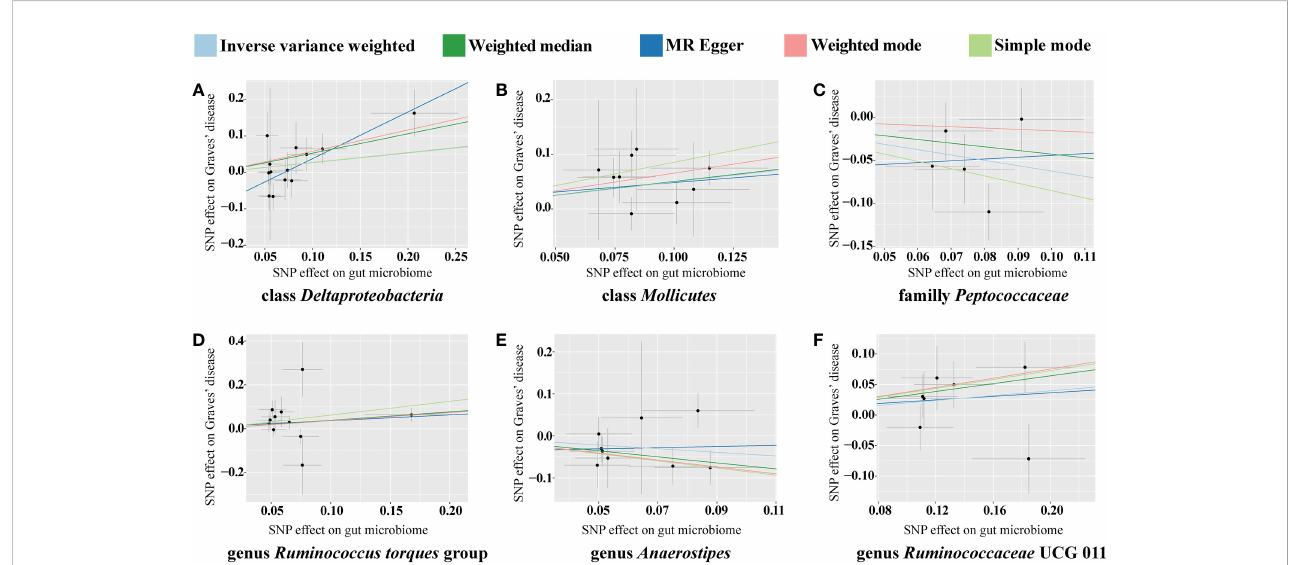
FIGURE 3 Scatterplot of the effect of the gut microbiome on Graves ’ disease (GD). The effect of the gut microbiome on GD is calculated through single nucleotide polymorphisms (SNPs), which provide an association between the gut microbiome and GD through fi ve Mendelian randomization (MR) methods (A – F) . In each plot, each dot indicates one SNP from the gut microbiome genome-wide association study (GWAS) summary dataset. The x -axis values represent the effect of SNPs on the gut microbiome. The numerical value of the x -axis position of each dot equals the absolute value of the b -value of each SNP, and the value of the horizontal error bar equals the standard error of the SNP from the gut microbiome GWAS summary dataset. The y -axis values represent the effect of the SNPs on GD. The numerical value of the y -axis position of each dot equals the opposite number of b -value of SNP, and the value of the vertical error bar equals the standard error of the SNP from the GD GWAS summary dataset. The b -values and standard errors for SNPs are part of the dataset used to describe the relationship between SNPs and phenotypes; they can be obtained directly by querying the GWAS summary dataset. Different colors of lines represent different MR methods: a causal effect of the gut microbiome on GD was calculated through inverse-variance weighting (IVW) (light blue), weighted median (dark green), MR Egger (dark blue), weighted mode methods (pink), and simple mode (light green). The slope value equals the b-value calculated using the fi ve methods and represents the causal effect of the gut microbiome on GD. The greater the absolute value of the slope, the greater the causal effect. Since the effect allele, an allele to which the effect estimate refers, was identi fi ed in the gut microbiome and GD GWAS summary datasets, a positive slope indicates that exposure is a risk factor, whereas a negative slope is the opposite. GD, Graves ’ disease; MR, Mendelian randomization; SNP, single nucleotide